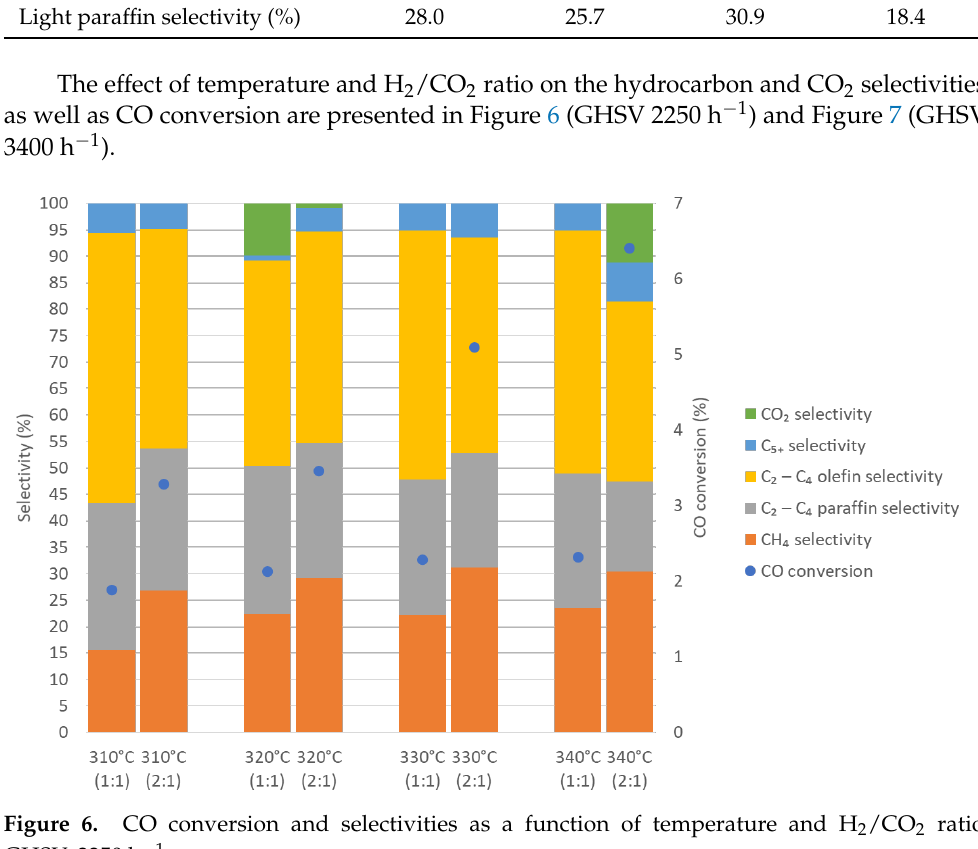
Figure 7. CO conversion and selectivities as a function of temperature and H 2 /CO 2 ratio. GHSV: 3400 h −1 .